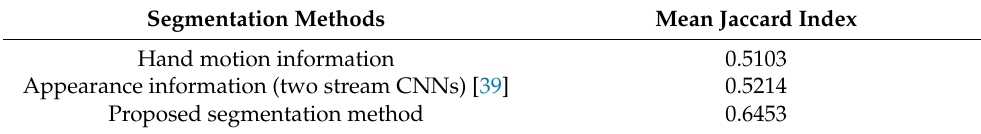
Table 1. Comparison of the performance of the proposed temporal segmentation method with the one of only using the hand motion information and the one of only using the appearance information on on the validation set of ChaLearn LAP ConGD